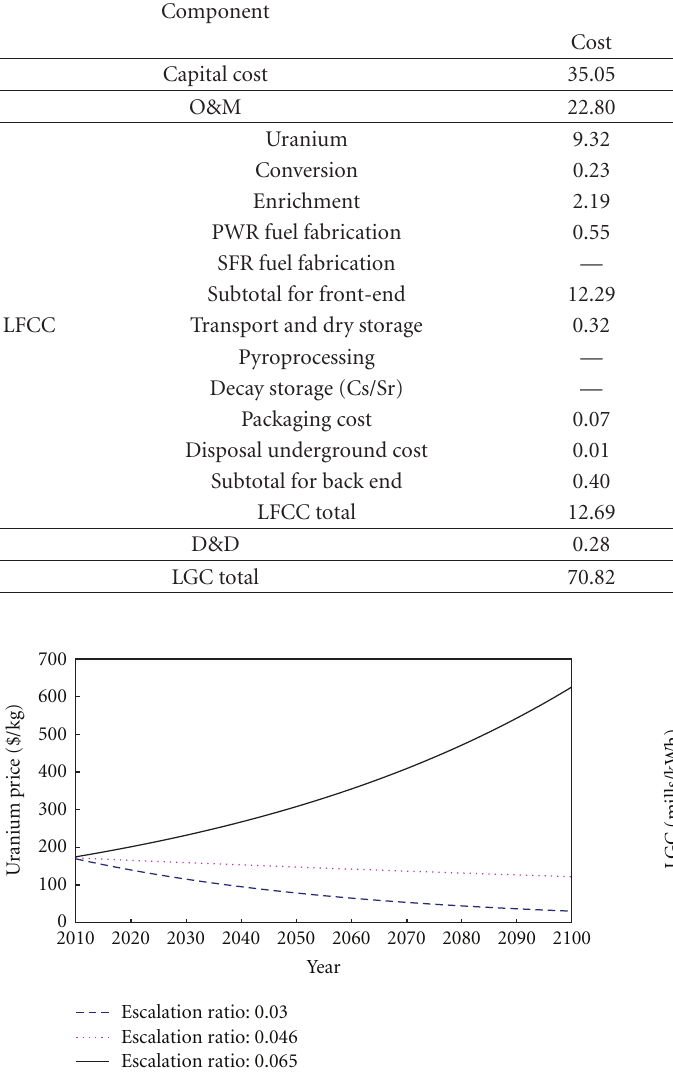
Figure 13: LGC dependent on escalation